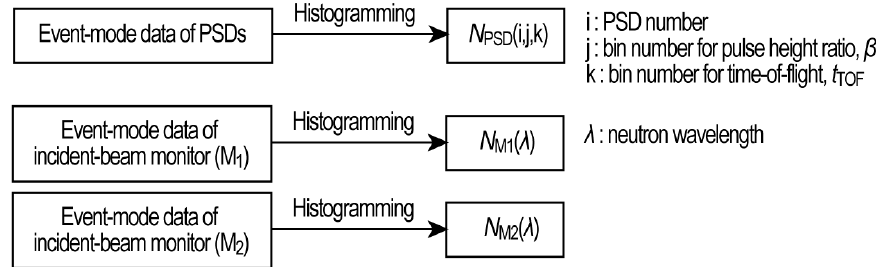
Figure 5. Schematic picture of charge-division method.